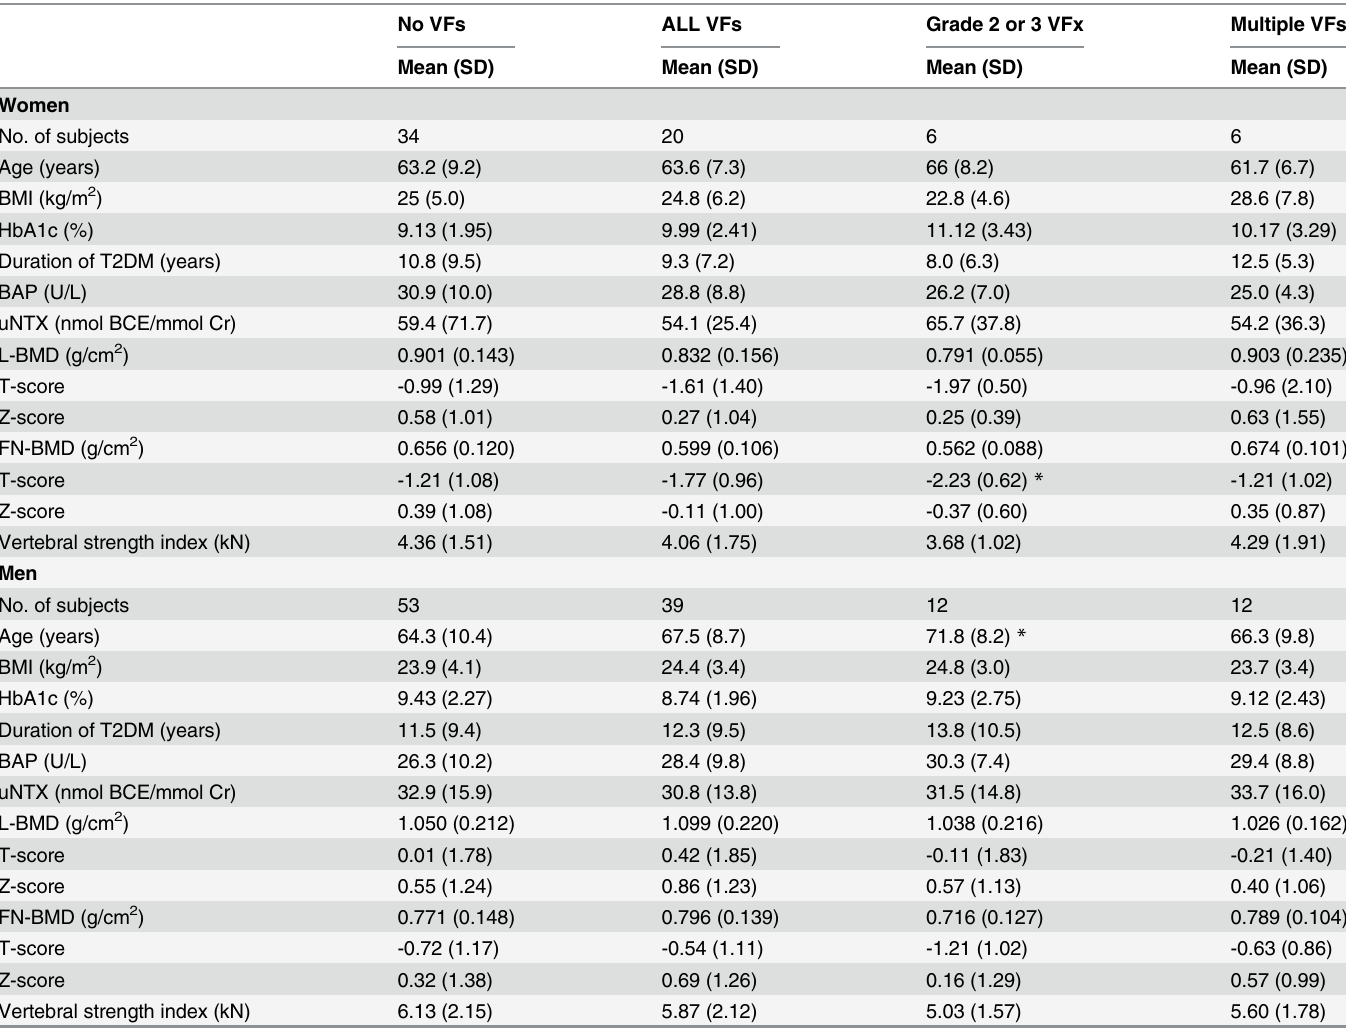
Table 4. Comparison of various parameters between the group without vertebral fractures and each group with vertebral fractures by various definitions. No VFs ALL VFs Grade 2 or 3 VFx Multiple